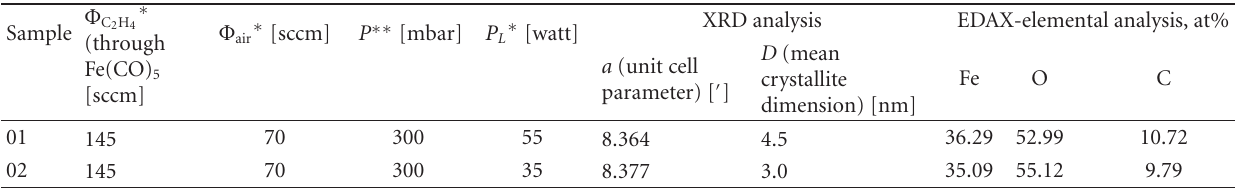
Table 1: Experimental parameters and main crystallographic characteristics (estimated from XRD analysis) for the as-synthesized nano iron oxide samples.